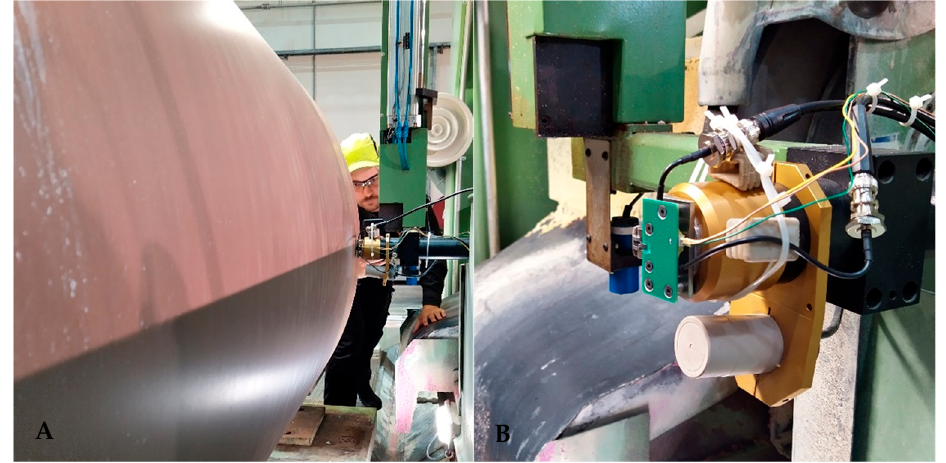
Figure 5. Paper roll with microprobe in the background ( A ). The roll measuring device in the picture ( B ) is of a different type to the one illustrated in Figure 7 and described in the text, but the head is similar.